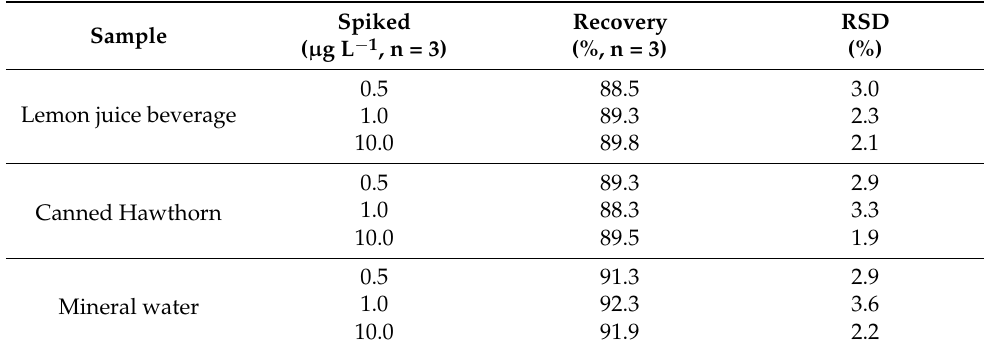
Table 1. Recovery rates of BPA obtained from spiked real samples using the developed MSPE-HPLC